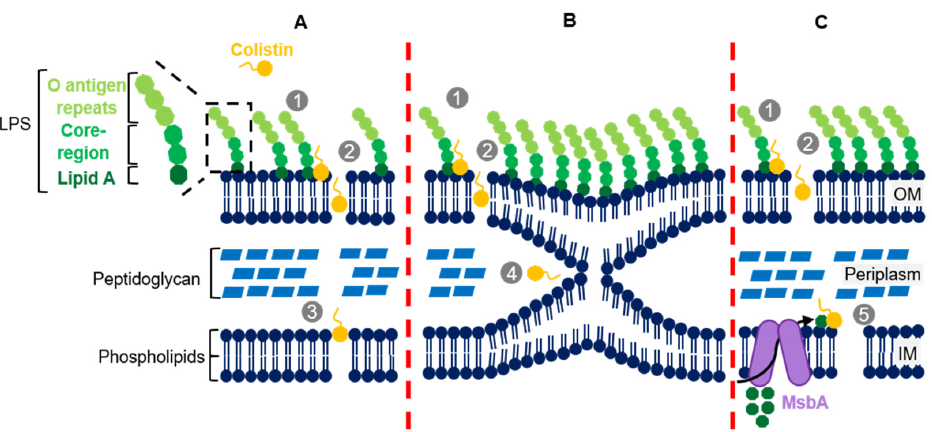
Figure 2. Colistin mechanisms of action: ( A ) lysis mechanism; ( B ) vesicle-vesicle contact pathway; ( C ) Inner membrane lipid A targeting. In OM, colistin induces the displacement of calcium and magnesium cations from lipid A in order to bind it ( 1 ). This electrostatic interaction, with the help of the hydrophobic regions of colistin, weakens the OM structure providing colistin access to periplasm ( 2 ). There, the way how colistin breaks IM is explained by the three hypotheses: the lysis mechanism ( A ), where colistin straddles the phospholipid bilayer decreasing the IM thickness and leading to cell lyses ( 3 ) [21,25]; a vesicle-vesicle contact pathway ( B ), where the colistin acyl tail induces the exchange of phospholipids between the outer leaflet of IM and inner leaflet of OM, resulting in the structure instability of theses membrane and cell death ( 4 ) [18,21,24]; fand, through inner membrane lipid A targeting ( C ), where colistin targets the lipid A molecules that are transiently in IM, after being translocated by MsbA from the cytoplasm (where they are synthesized) and before being transported to OM, which will induce cytoplasmic content leakage and consequently cell death ( 5 ) [26,27]. LPS—lipopolysaccharide; OM—outer membrane; IM—inner membrane.